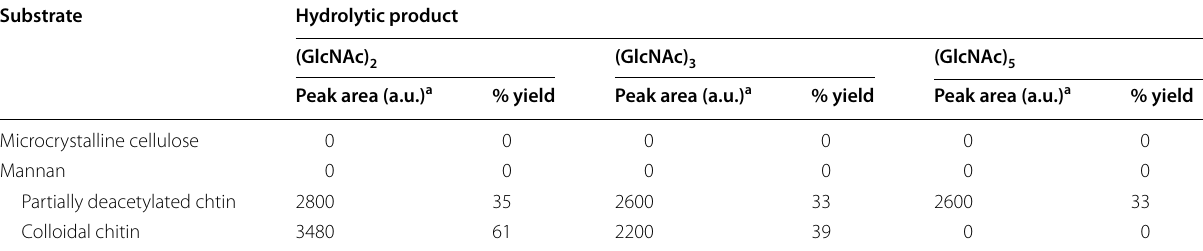
Table 1 Quantitation of chitooligosaccharide products obtained from the hydrolysis of different polysaccharides by Vh ChiA